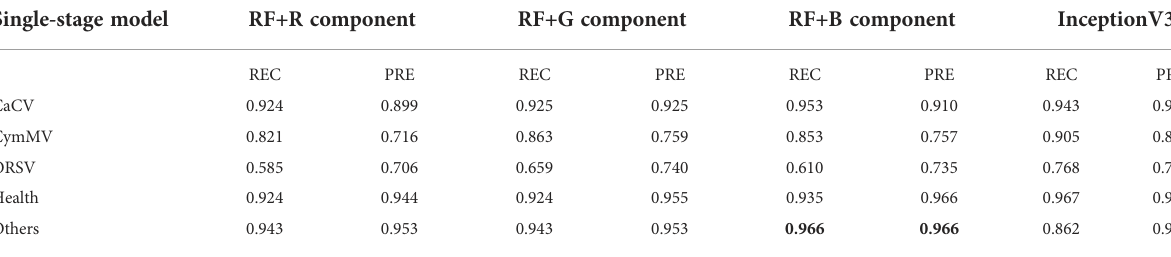
TABLE 4 The identi fi cation recall and precision of single-stage models with leaf segmentation. Single-stage model